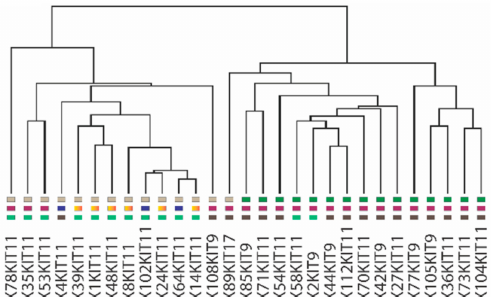
Figure 3. Supervised hierarchical clustering based on di ff erential gene expression discriminates imatinib-naïve (IM-n) and imatinib-resistant (IM-r) gastrointestinal stromal tumor (GIST) samples. Transcript expression profiles were determined using the A ff ymetrix platform (U133 plus 2) of 29 fresh frozen samples derived of IM-n (n = 14) and IM-r (n = 15) GISTs. Depicted is the cluster tree of a supervised hierarchical clustering based on 352 significant ( p < 0.008, False Discovery Rate (FDR) < 10%), di ff erentially expressed transcripts. Note that 100% of the IM-r samples are clustered together with a single IM-n GIST sample. The colored squares beneath the graph designate imatinib-naïve and imatinib-resistant samples, the malignancy risk and location of the tumors (see Figure 1). Note that the sample codes below also indicate which KIT exon is